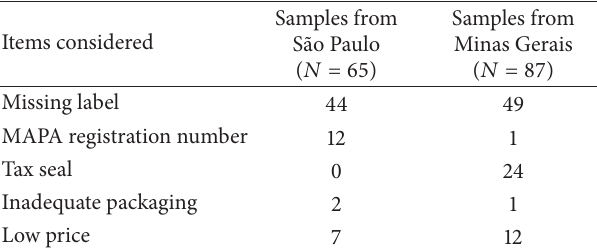
Table 1: Number of samples among the 152 samples of alcoholic beverages collected from the states of S˜ao Paulo (number of samples 65) and Minas Gerais (number of samples 87), Brazil, which are unlabeled and did not display a MAPA registration number or tax